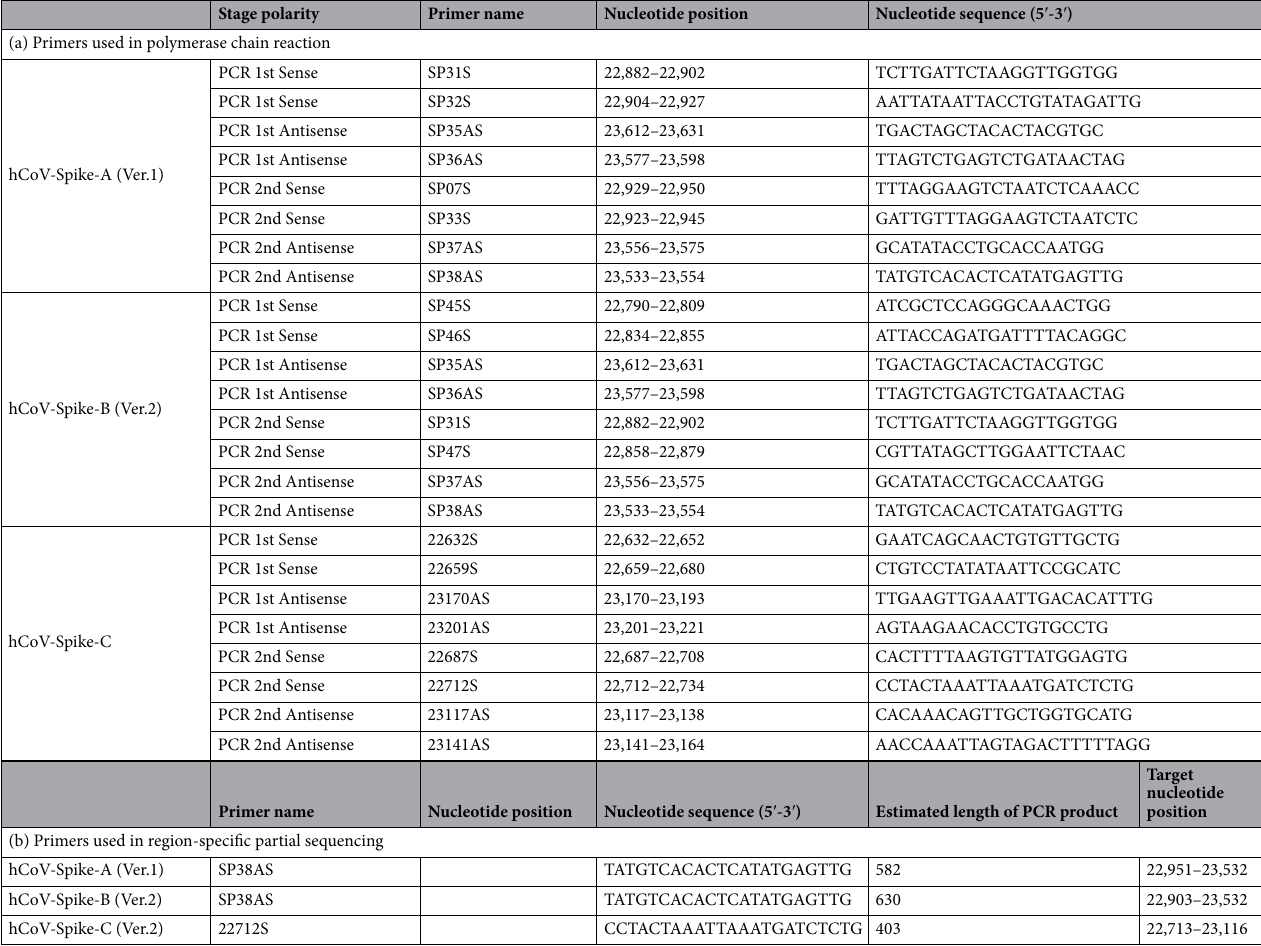
Table 1. SARS-CoV-2 specific primers used for partial sequences of particular